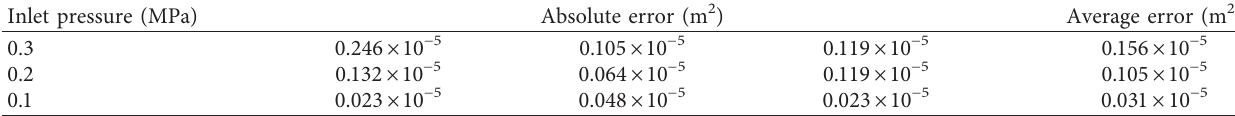
Table 4: Absolute error under different pressures in three